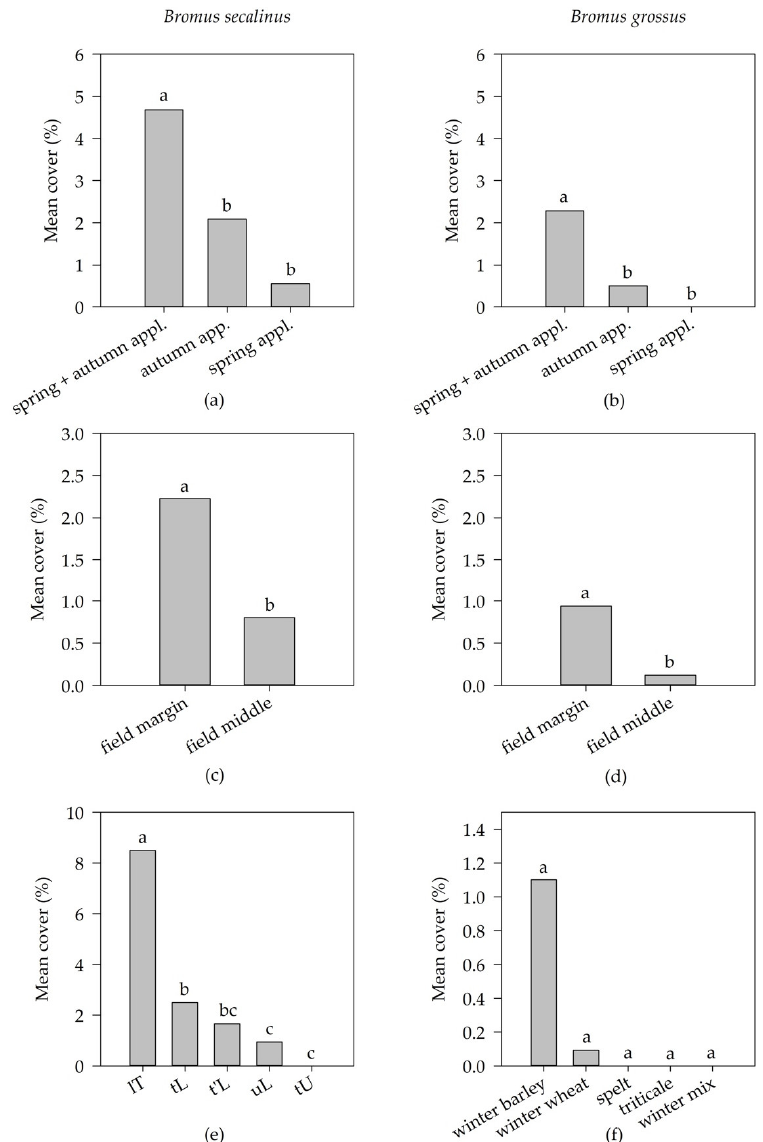
Figure 5. Factors influencing the mean cover (%) of ( a , c , e ) Bromus secalinus and ( b ) Bromus grossus in the Gäu region. ( a , b ) Timing of herbicide application; ( c , d ) location in the field; ( e ) soil type (lT = loamy clay, tL = clayey loam, t’L = weakly clayey loam, uL = silty loam, tU = loamy silt); and ( f ) crop species. Means with different letters represent significant differences according to the Tukey HSD test ( p ≤ 0.05).